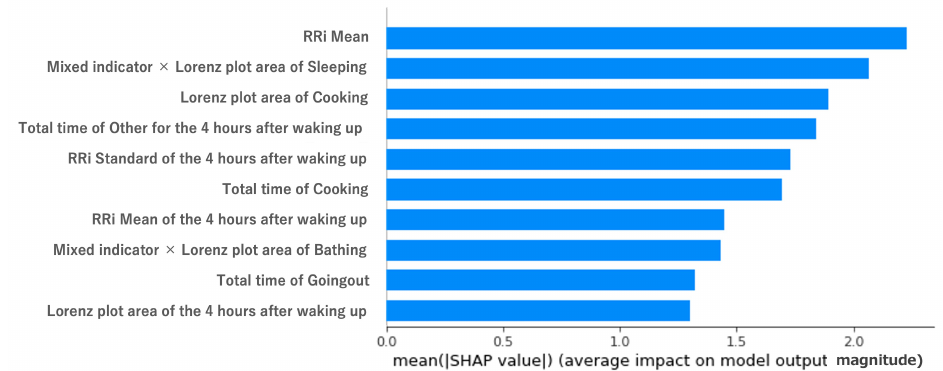
Figure 8. Impact of features on model output by SHAP values for MQ. Vertical axis: each feature (in decreasing order of contribution, top 10). Horizontal axis: value of the contribution variable (SHAP value).